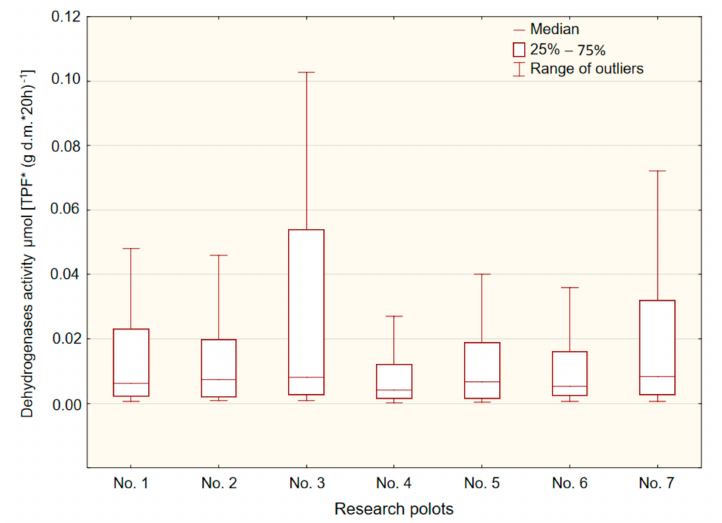
Figure 6. The distribution of data of dehydrogenases activity in A horizon.